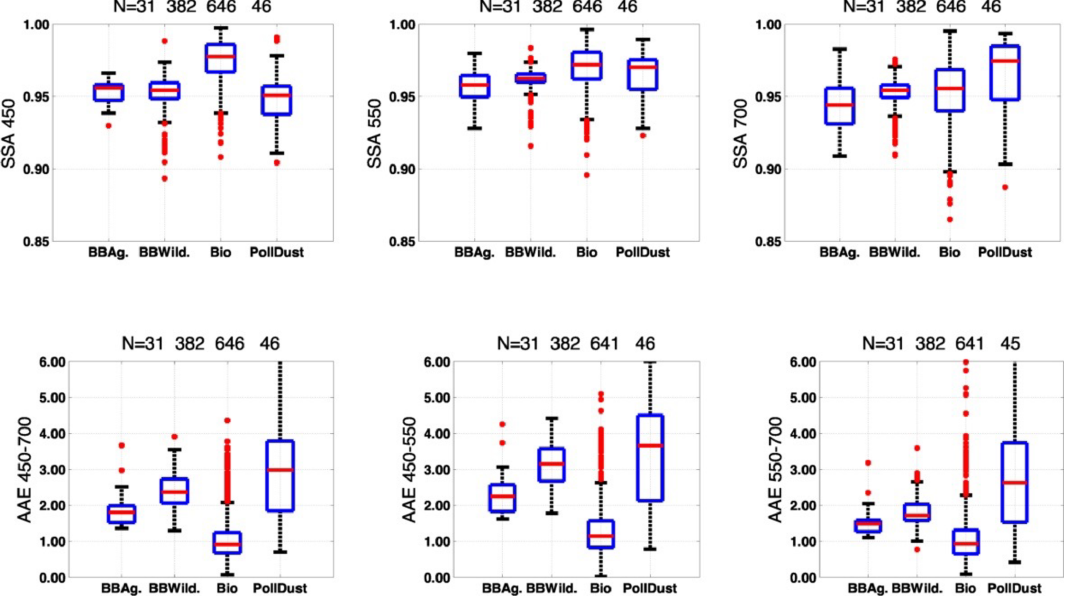
Figure A3. SSA (450, 550 and 700nm) and AAE (450–700nm, 450–550nm, 550–700nm) per PS-AMT. In each blue box, the red horizontal line indicates the median, and the bottom and top edges of the box indicate the 25th and 75th percentiles, respectively. The black whiskers extend to the most extreme data points not considered outliers, and the outliers are plotted individually using red points. AAE: absorption Ångström exponent; SSA: single scattering albedo. Numbers in the title correspond to the number of points behind each box–whisker plot for the respective BBAg., BBWild., Bio. and PollDust